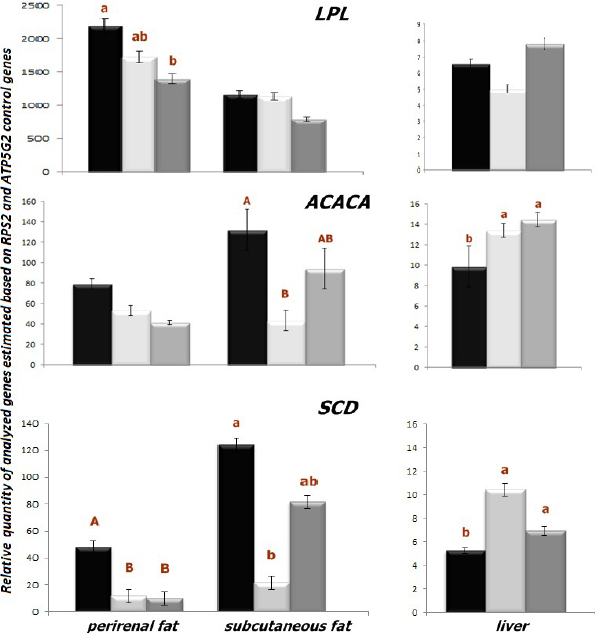
Figure 1. The transcript level for LPL , ACACA and SCD genes es- timated in fat and liver tissues according to diet supplementation: complete pellet mixture (black column), grass addition (while col- umn) and red clover addition (gray column). Data are presented as mean ± standard error; means with a, b and A, B differ significantly at P <0.05 and P <0.01,